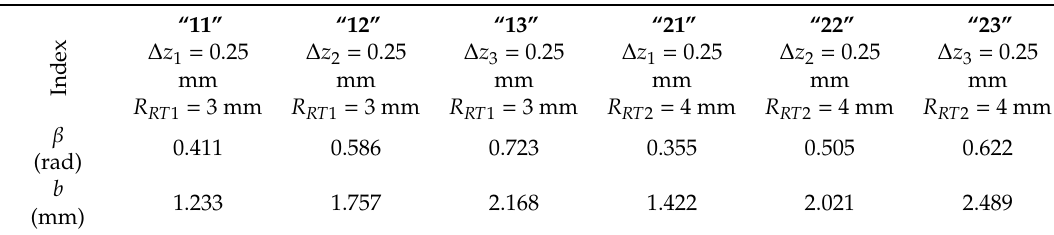
Table 3. The results for time obtained from Equation (3) expressed in seconds